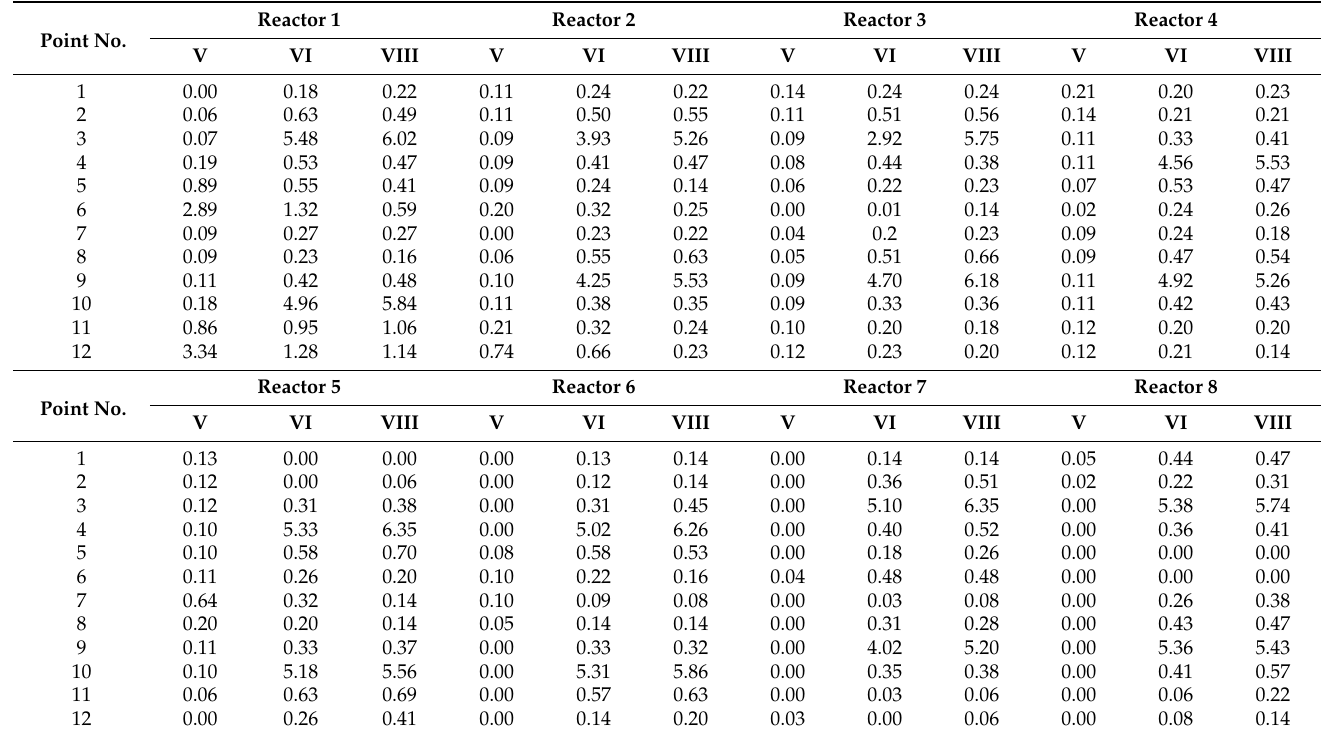
Table 2. Oxygen concentrations [mg/L] at measuring points 0.5 m above the bottom level. Roman numerals indicate months of research.